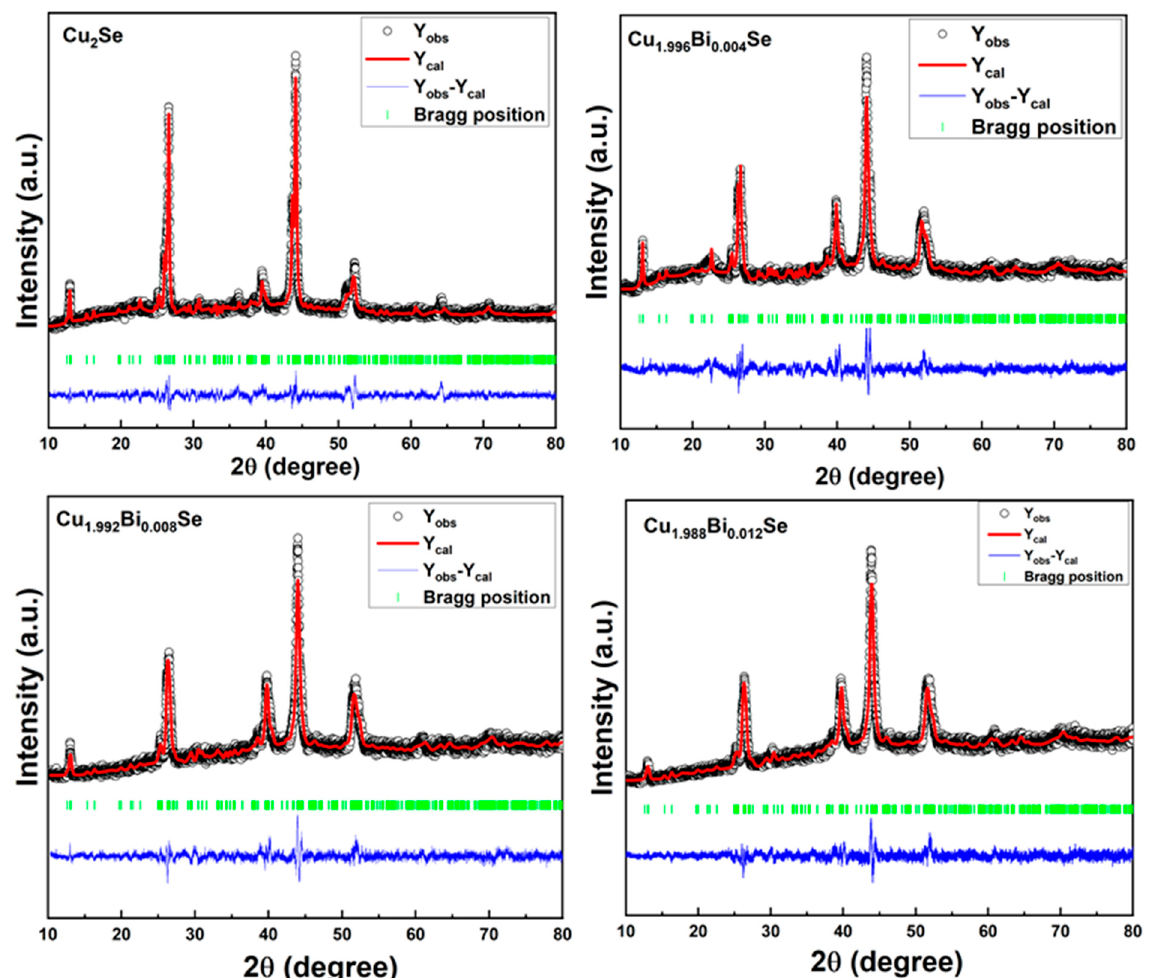
Figure 2. Rietveld refinement X-ray plots of Cu 2 − x Bi x Se samples.